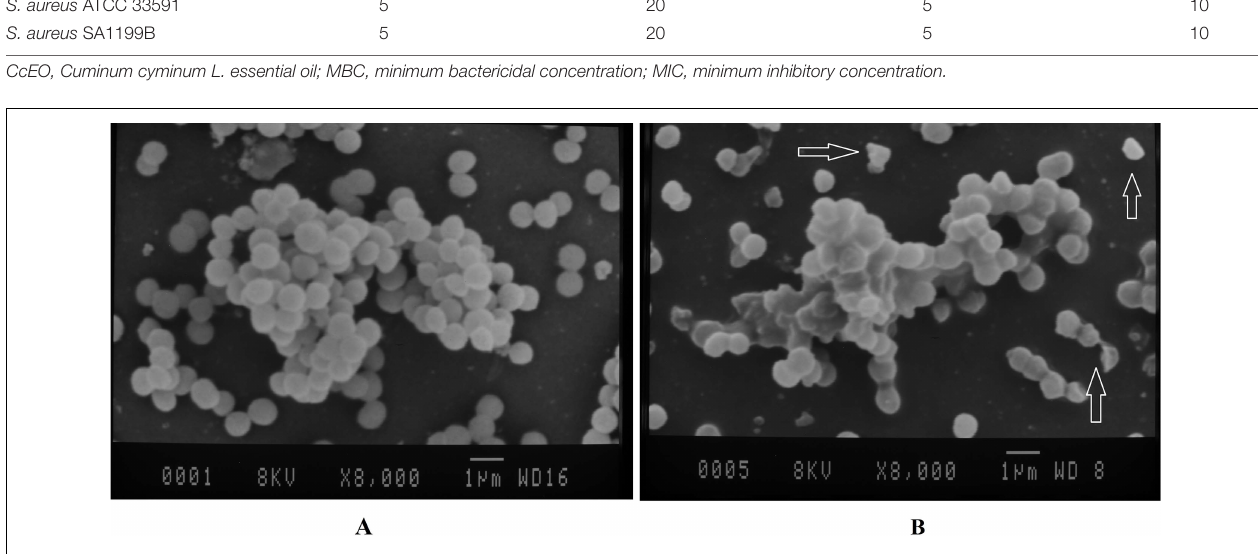
calculated using the 2 − (cid:49)(cid:49) CT method as described previously by Livak and Schmittgen